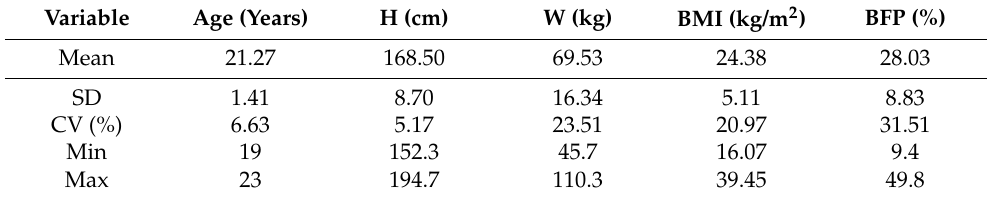
Table 1. Statistical indicators for body composition parameters in the experimental group ( n = 50).